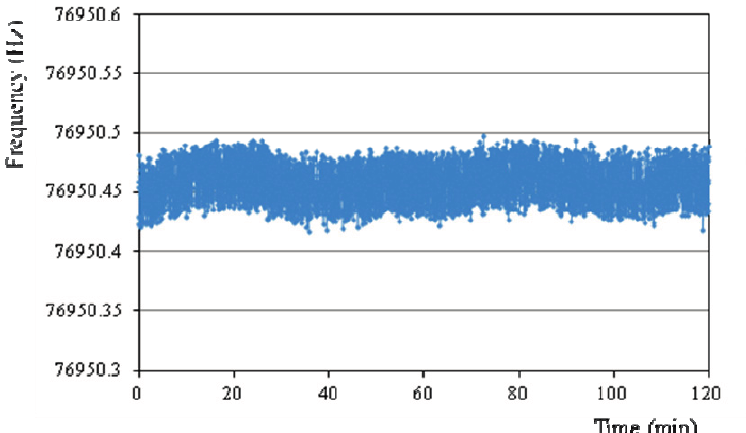
Figure 8. The measured zero bias stability with the oscillation circuit.